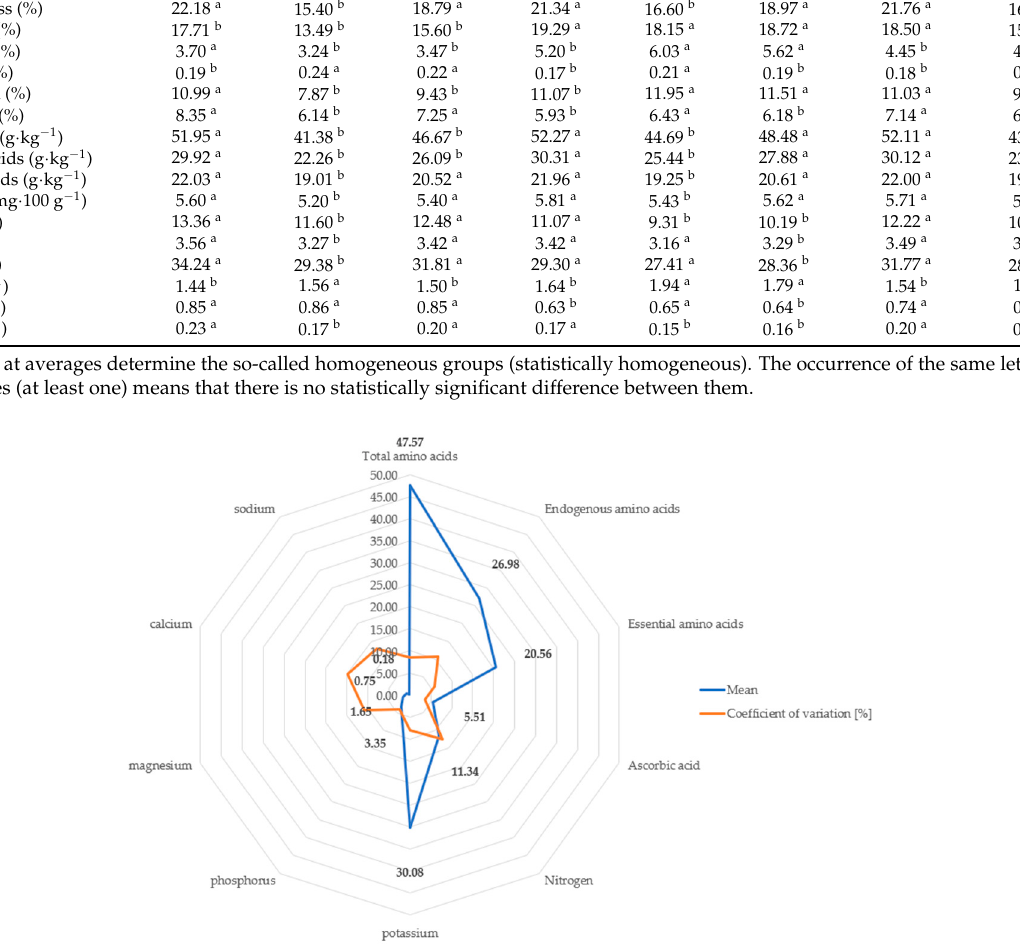
Table 4. Chemical composition of H. tuberosus tubers depending on geographic location and cultivars (2015–2017 average). Features